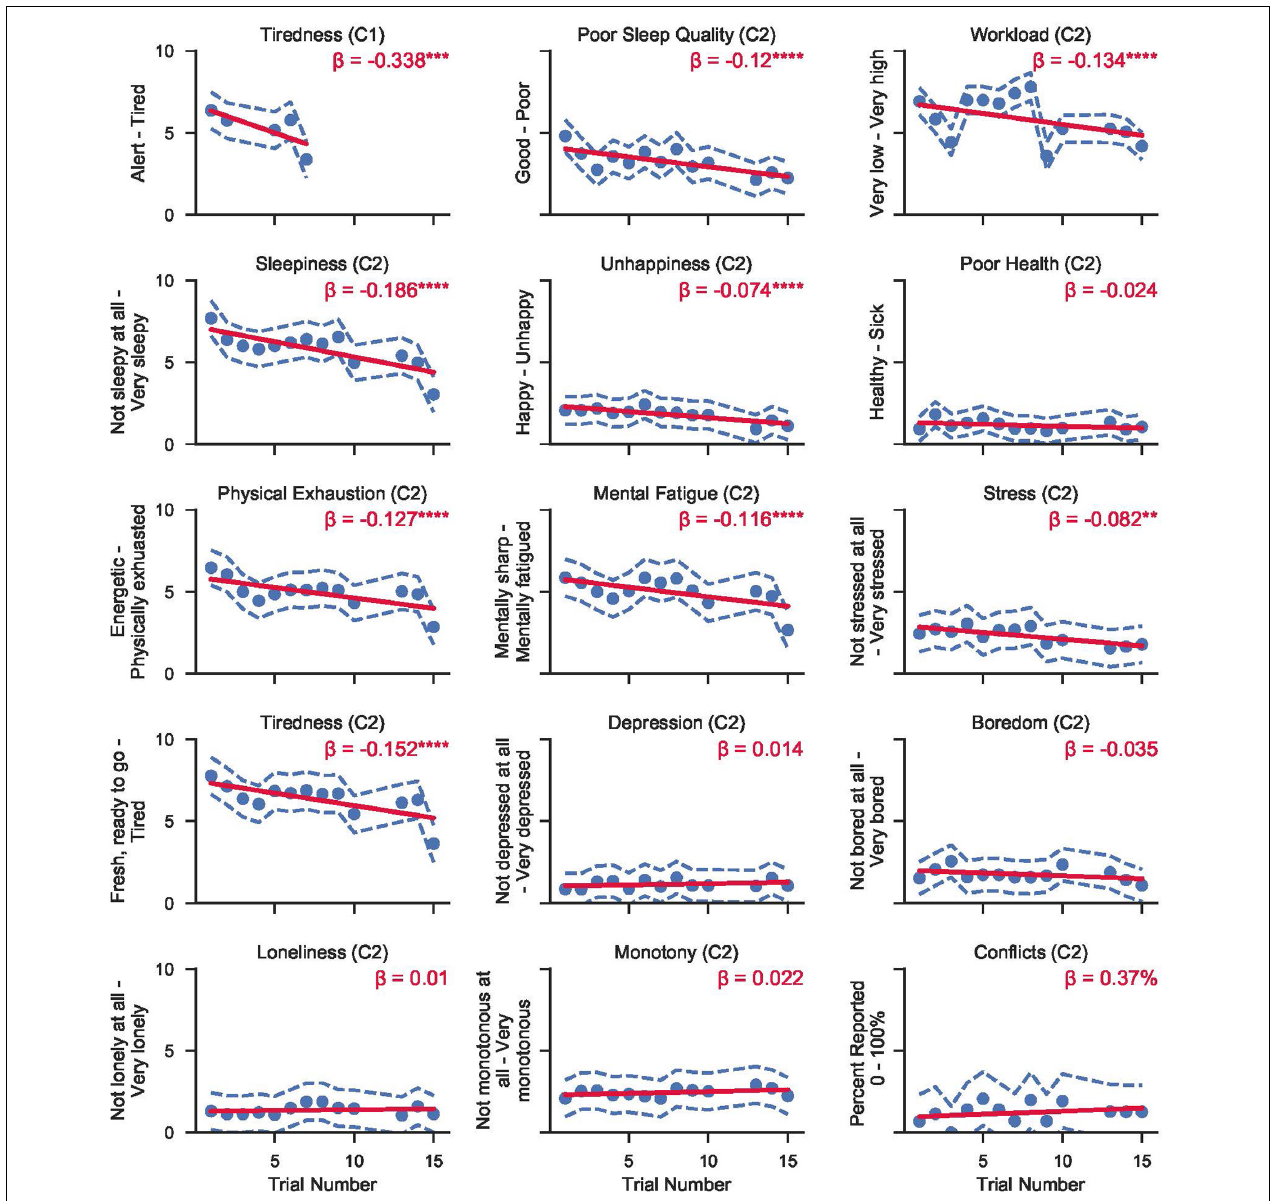
FIGURE 3 | Raw (untransformed) survey response scores from the surveys administered in either campaign 1 (C1) or campaign 2 (C2) at HERA. Circles refer to the mean score across subjects from either campaign for each trial number. Dashed blue lines show the 95% CI range around each mean point. Solid red lines represent mixed effects linear models fit to the data within each question. β refers to the linear slope of the regression model (i.e., change in raw score per trial). Asterisks refer to significance levels after adjusting for multiple testing with the false discovery rate method with p -values referring to H 0 : regression line slope = 0. (* p < 0.05; ** p < 0.01; *** p < 0.001; **** p <